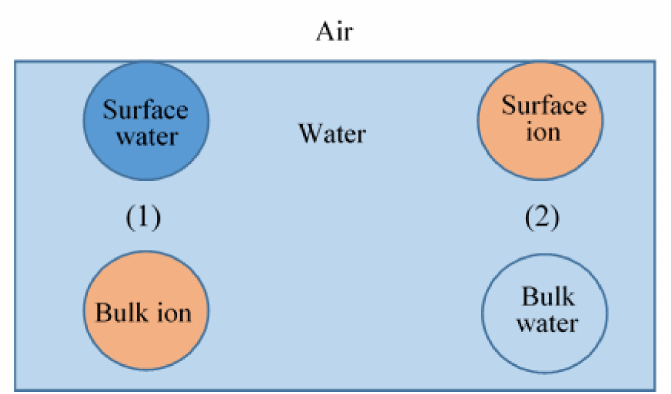
Figure 1. Two basic energetical states: ( 1 ) bulk ion and N w surface water molecules; ( 2 ) surface ion and N w bulk water